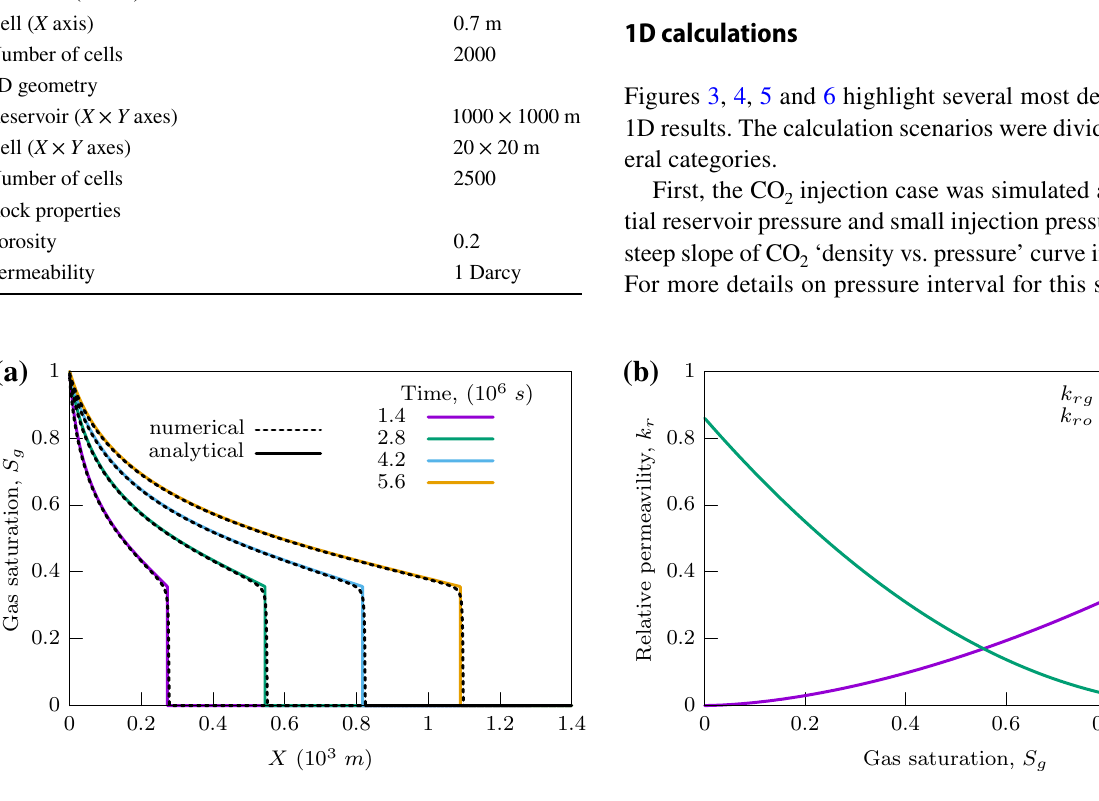
Fig. 1 Validation. 1D model. a Saturation profiles. Comparison of numerical solution with Buckley–Leverett analytical model. b Relative per- meability curves